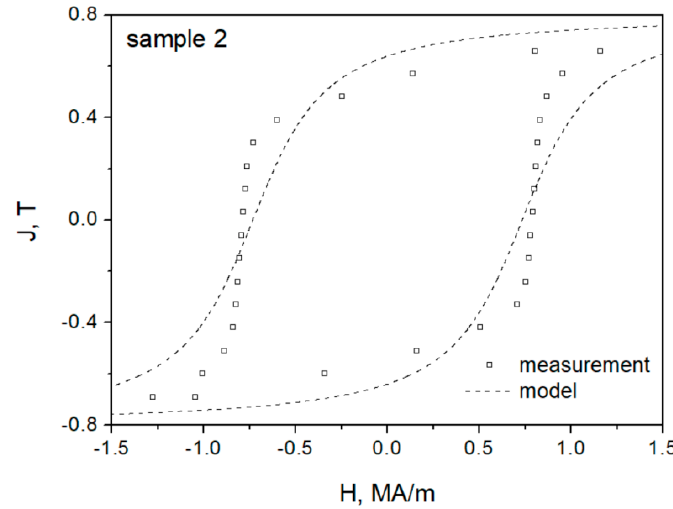
Figure 10. Modeled and measured hysteresis curves for Sample 1.